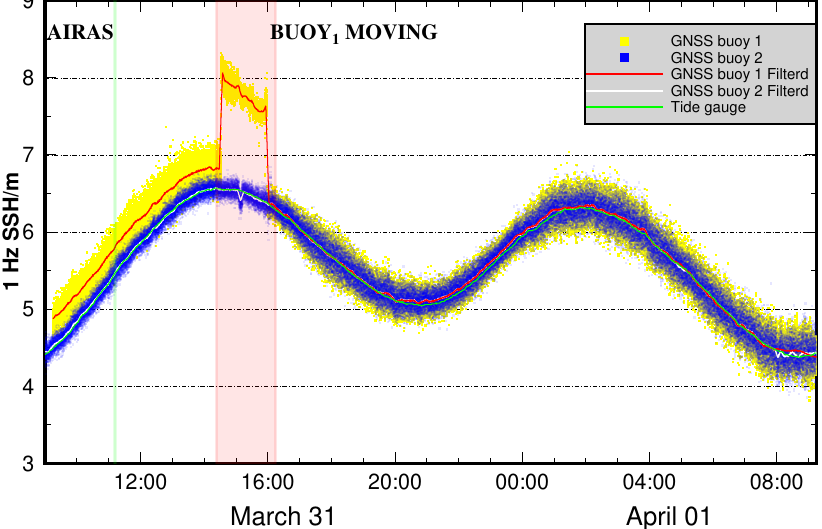
Figure 8. Sea surface heights (SSHs) retrieved from GNSS buoys and in situ tide gauge data. The AIRAS campaign was conducted from 09:00 local time (LT) on 31 March 2019 to 14:00 LT on 31 March 2019. The AIRAS data used in this investigation were collected at approximately 11:00 LT. During 14:20–16:00 LT, GNSS buoy 1 was transported by ship to the location of buoy